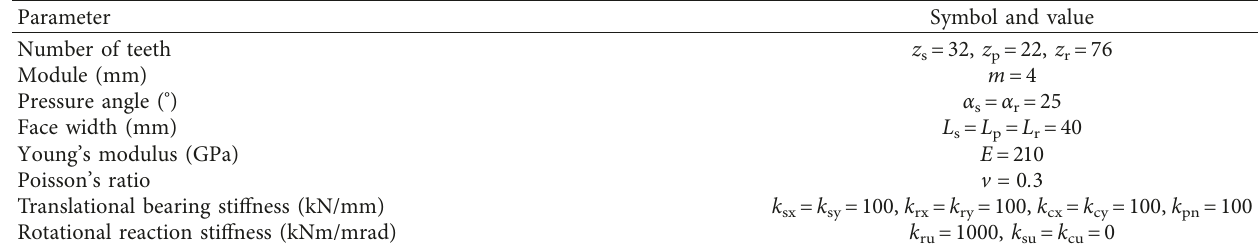
Figure 6: (a) Flowchart of the GA computational model; (b) encoding of individual; (c) crossover; (d) mutation. Table 1: Basic parameters of the example